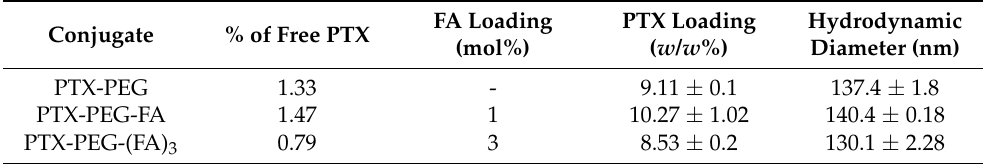
Table 2. PTX-PEG, PTX-PEG-FA and PTX-PEG-(FA)3 reaction yields ( w / w )%, loading% w / w of FA and PTX and mean hydrodynamic diameter of polymeric structure in PBS at pH